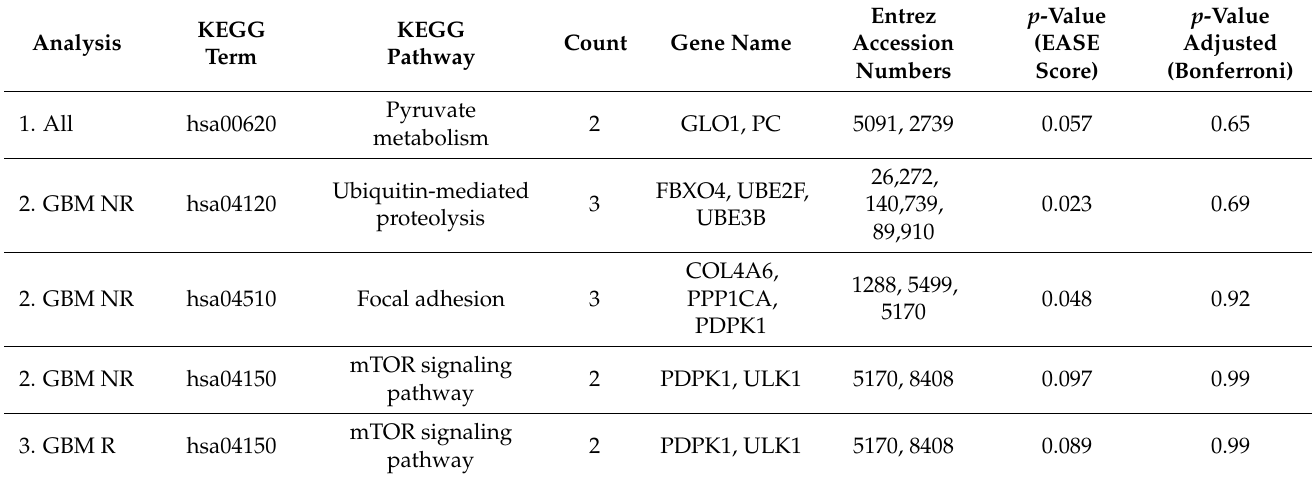
Table 2. Results of the gene-enrichment and functional annotation analyses for All gliomas, GBM NR, and GBM R gene lists. The genes in KEGG pathways that were considered to be “enriched” were identified using a p -value (EASE score) cut-off of 0.1 for significance. The p -values adjusted for multiple hypothesis testing using the Bonferroni method are also provided. KEGG terms, the identifier for each pathway used by the KEGG database are listed from the functional annotation clustering report. Count is the number of genes involved in the enriched